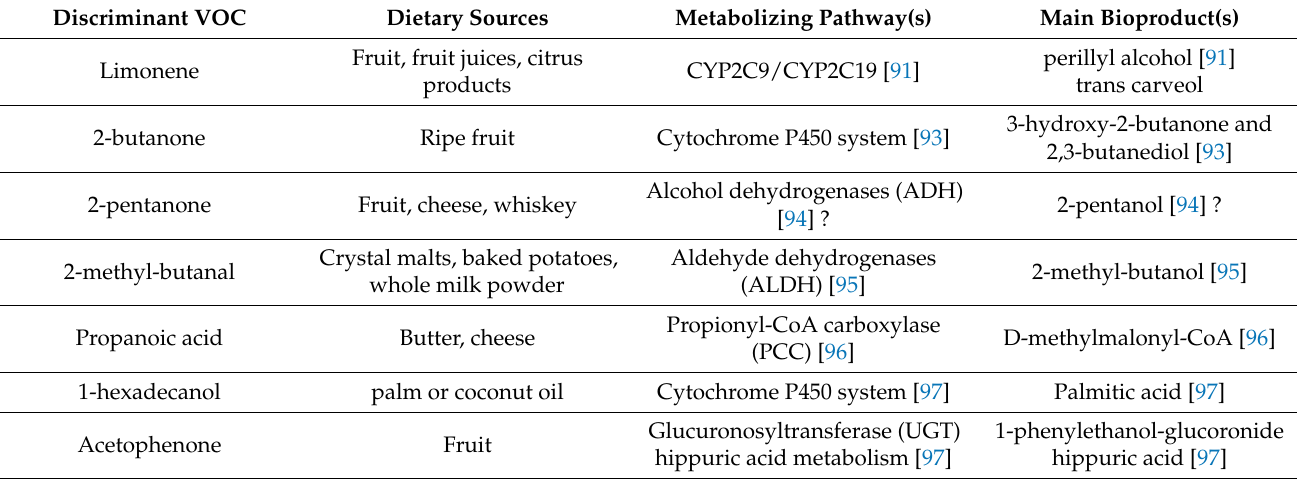
Table 2. Dietary sources and metabolic pathways involved in the biotransformation of exogenous VOCs found discriminant for chronic liver diseases. ? indicated the pathway has not been fully